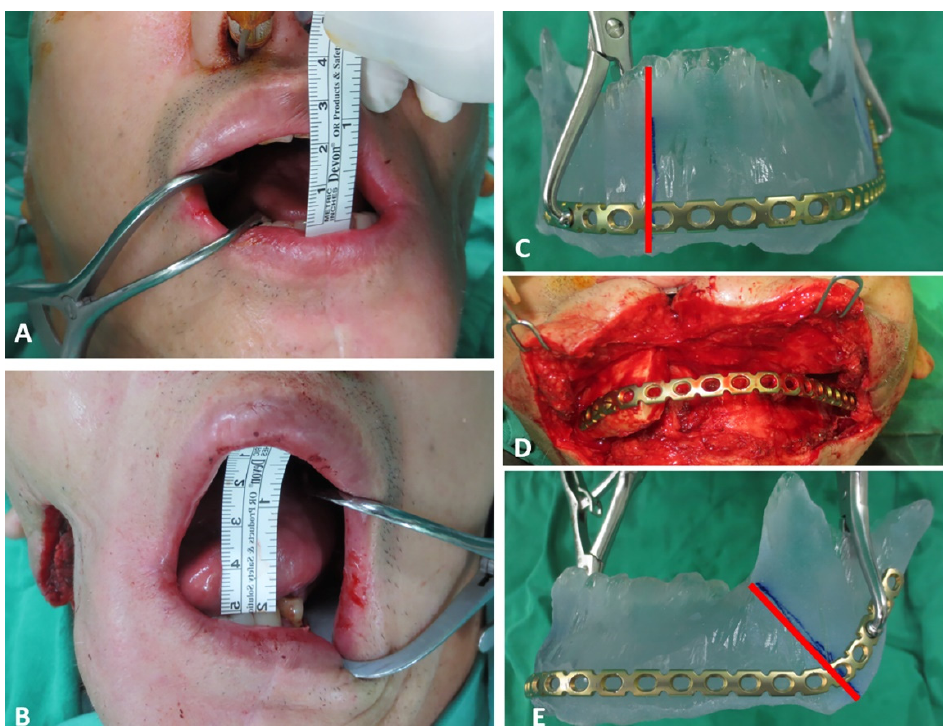
Figure 6. Pre-bent individualized plates adaptation in edentulous patients. ( A , B ) Mouth opening before and after coronoidectomy and contracture release. ( C , E ) Marking of resection margins on the model as per intraoperative scenario, taking linear measurements from mandibular angle or mandibular notch as a reference. (Red line) ( D ) Pre-bent reconstruction plate fixed to the residual mandibular segments with the guidance of marked holes placed with reference from the model.